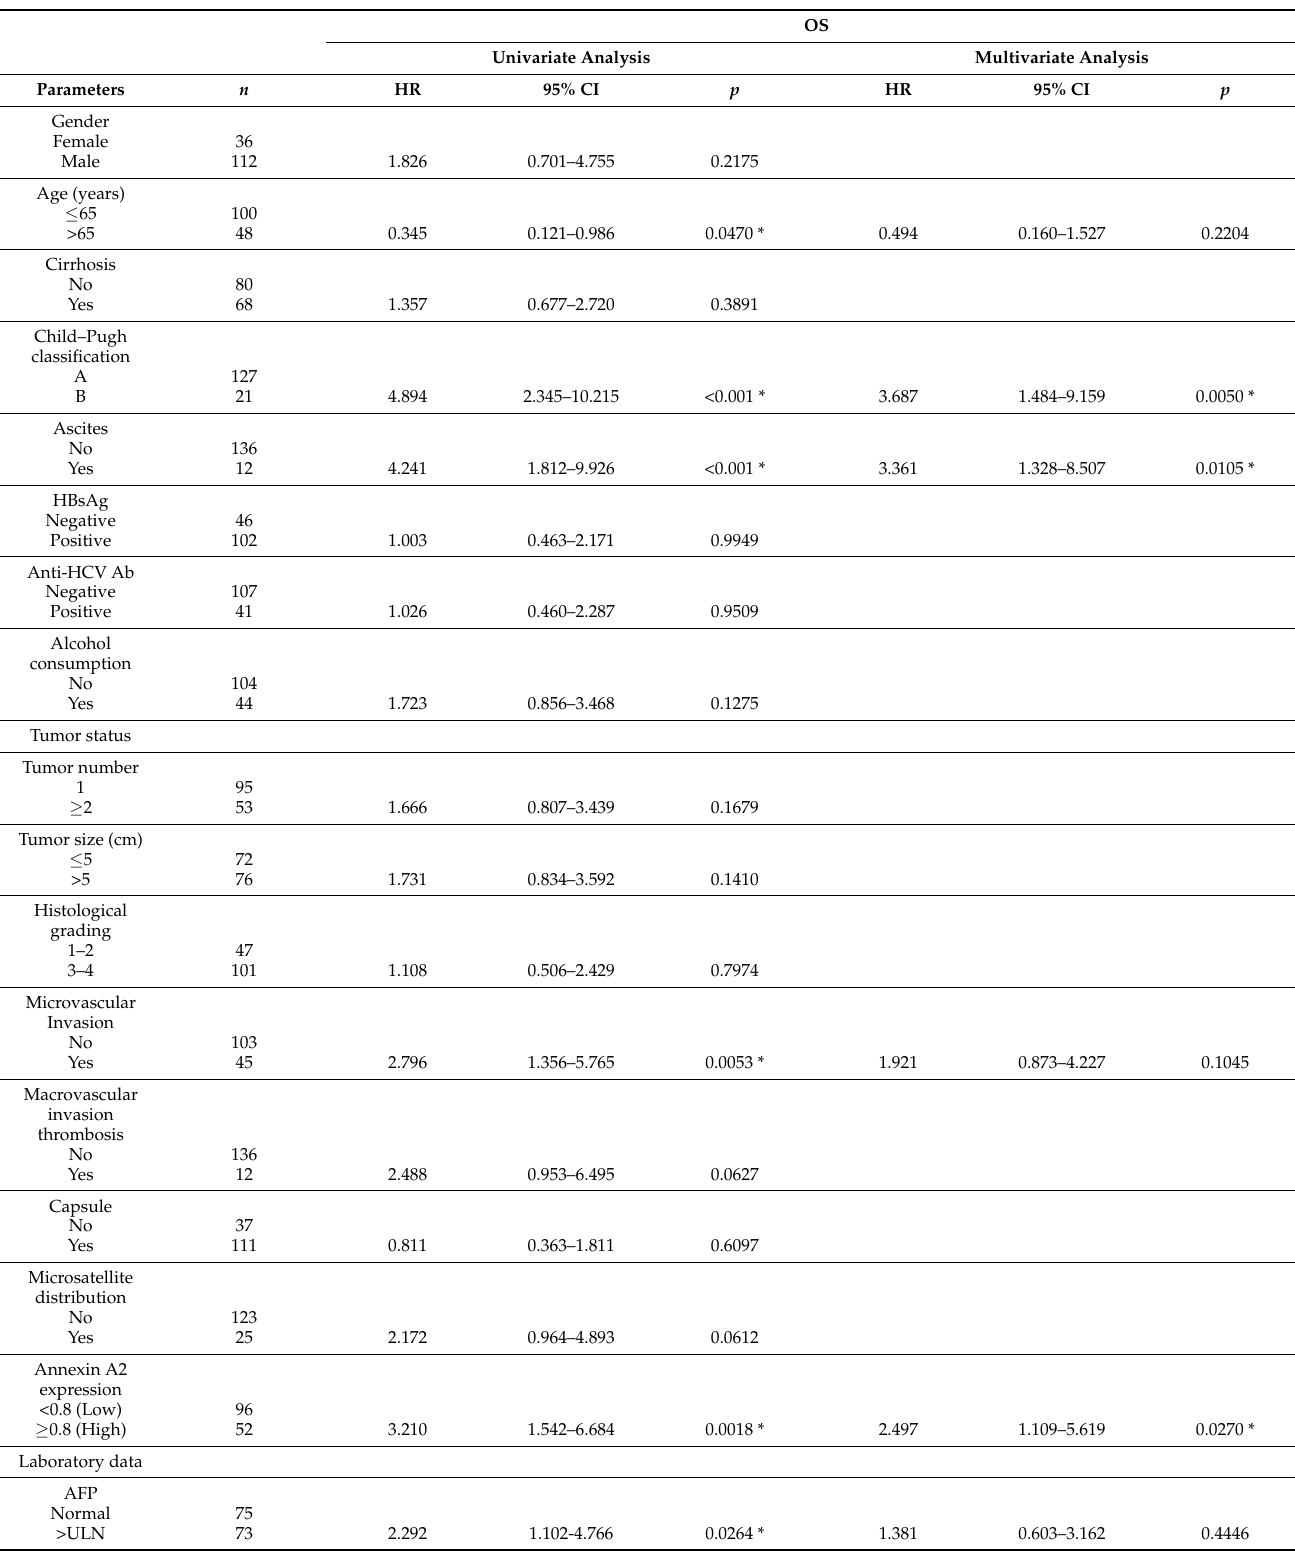
Table 4. Analysis of factors that influenced OS of all patients (cohort